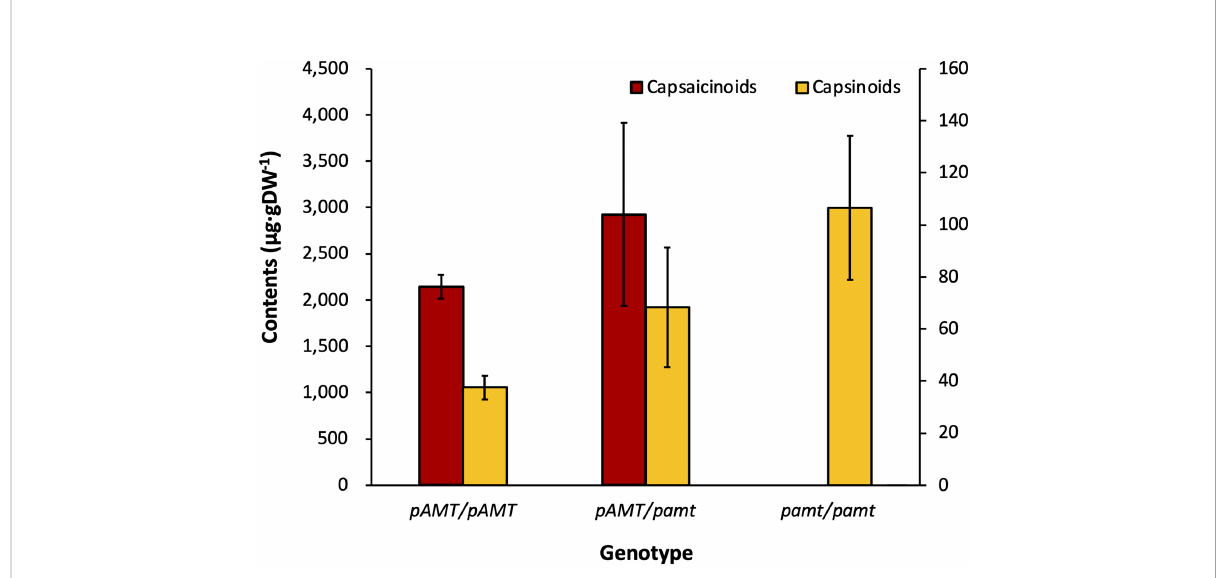
FIGURE 4 Capsaicinoid and capsinoid contents by genotypes of pAMT in the ‘ PP ’ F 2 population. The capsaicinoid content was not able to be determined in the group of homozygous pamt 11 , whereas the capsinoid content was the largest among all genotype